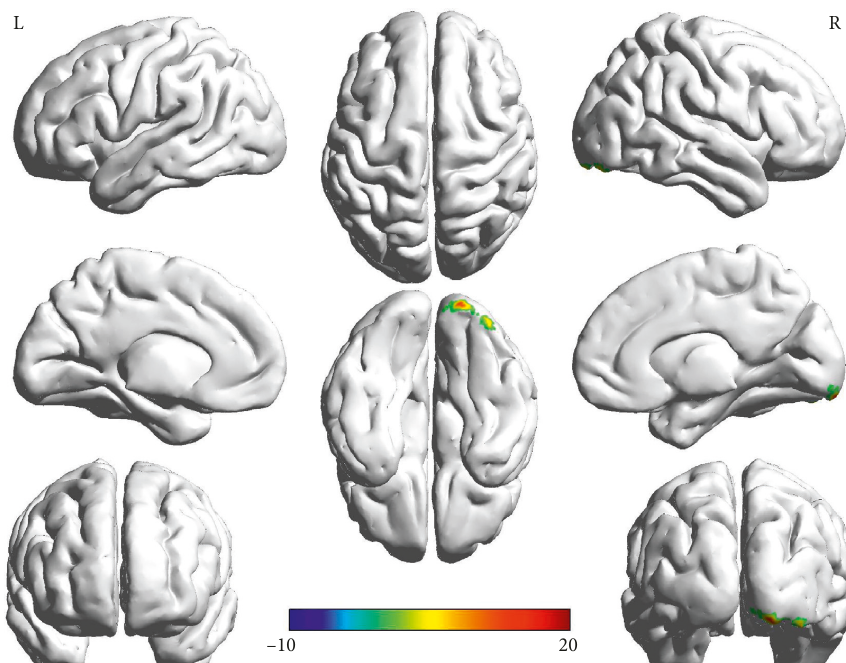
Figure 1: Main effect of groups on ALFF in PD and HC found in the right occipital lobe (right inferior occipital gyrus/lingual gyrus/fusiform gyrus). The finding was obtained via two-way factorial analysis of covariance (ANCOVA: groups notypes: Ser/Ser carriers and the Gly carriers) adjusting for age, gender, and education. A corrected threshold by Monte Carlo simulation was set at P 0 . 001. The color bar indicates the F values from ANCOVA. Abbreviations: PD, Parkinson’s disease; HC, healthy control; ALFF, amplitude of low-frequency fluctuations; R, right; L, left. <